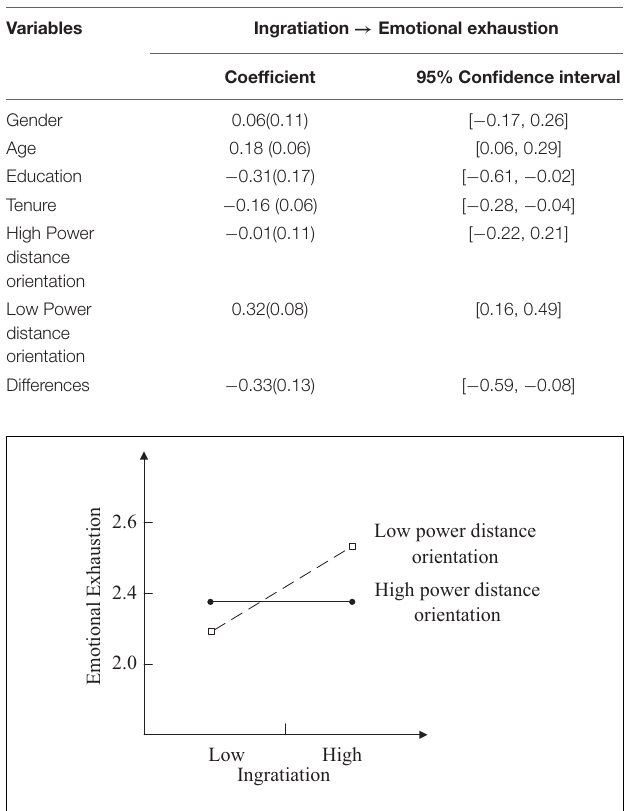
FIGURE 1 | Moderating effect of power distance orientation on the relationship between ingratiation and emotional exhaustion.